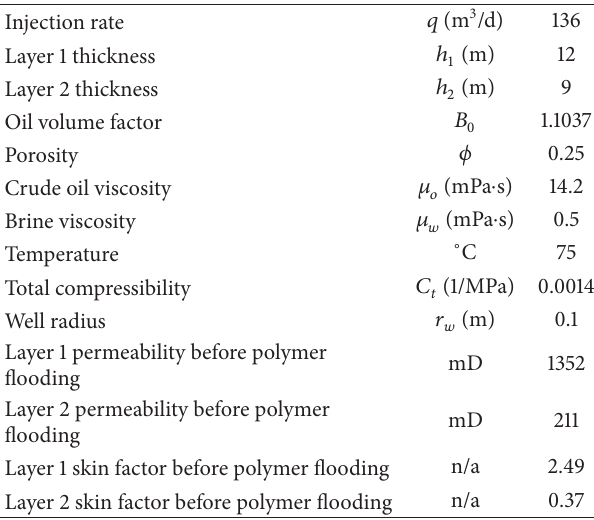
Table 7: Basic parameters of well and reservoir for 5-225 field test.